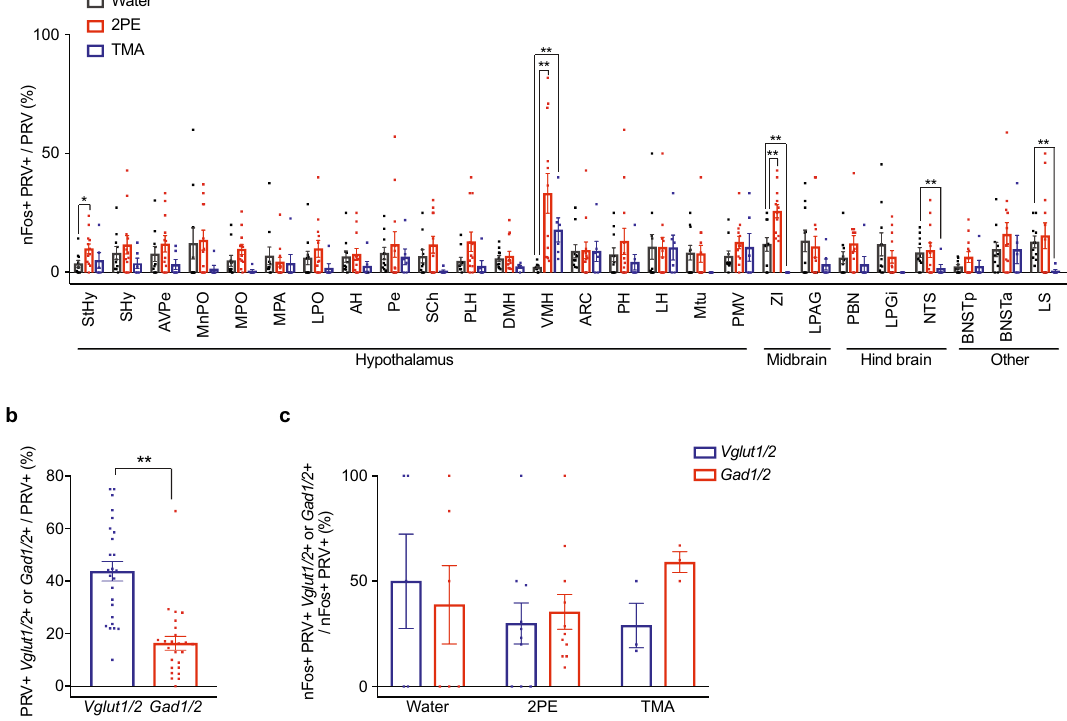
Figure 3. Blocking odorants activate inhibitory neurons upstream of CRHNs in VMH. ( a ) On d3pi after CRHN infection with PRVB177, animals were exposed to 2PE, TMA, or water and brain sections were costained for PRV and nFos. The percentage of PRV+ neurons in individual brain areas that were colabeled for nFos was then determined (nFos+ &PRV+/PRV+ (%). Column heights indicate means, error bars indicate S.E.M., and dots in the same column indicate different animals. n = 6–12 per condition. Unpaired t test, *P < 0.05, **P < 0.01. PRV+ neurons in the VMH showed significant activation by both 2PE and TMA. ( b,c ) Following exposure to water, 2PE, or TMA, VMH sections were costained for HA (PRV), nFos, and markers of glutamatergic neurons (Vglut1/2) or GABAergic neurons (Gad1/2). Many PRV+ VMH neurons were colabeled for either Vglut/2 or Gad1/2 ( b ). Both 2PE and TMA activated Vglut1/2 and Gad1/2+ PRV+ neurons in the VMH ( c ). Column heights indicate means, error bars indicate S.E.M., and dots in the same column indicate different animals. n = 3–12 per condition. Unpaired t test, **P <